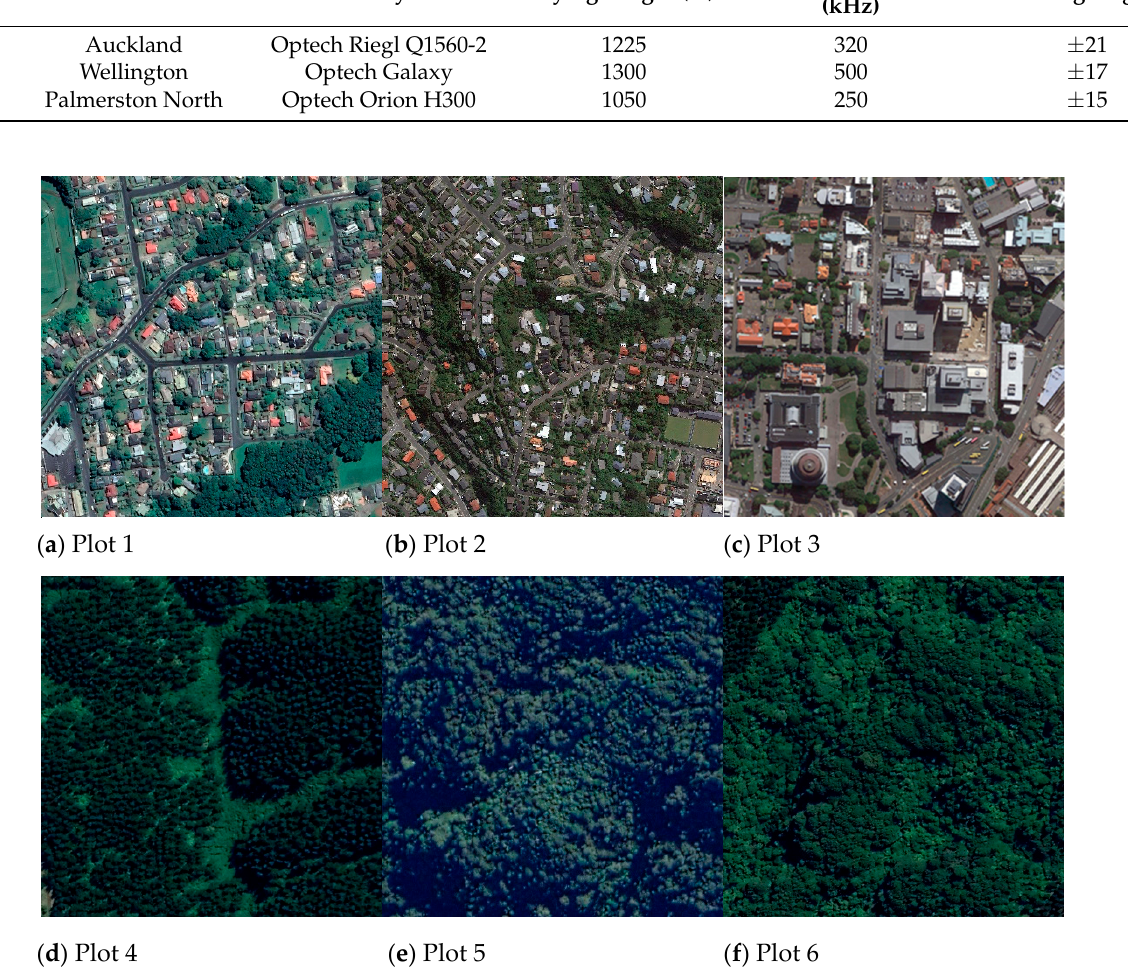
Figure 6. Orthoimages of the six study sites. Plots 1–3 belong to urban areas ( a – c ) and plots 4–6 belong to forest areas ( d – f ).